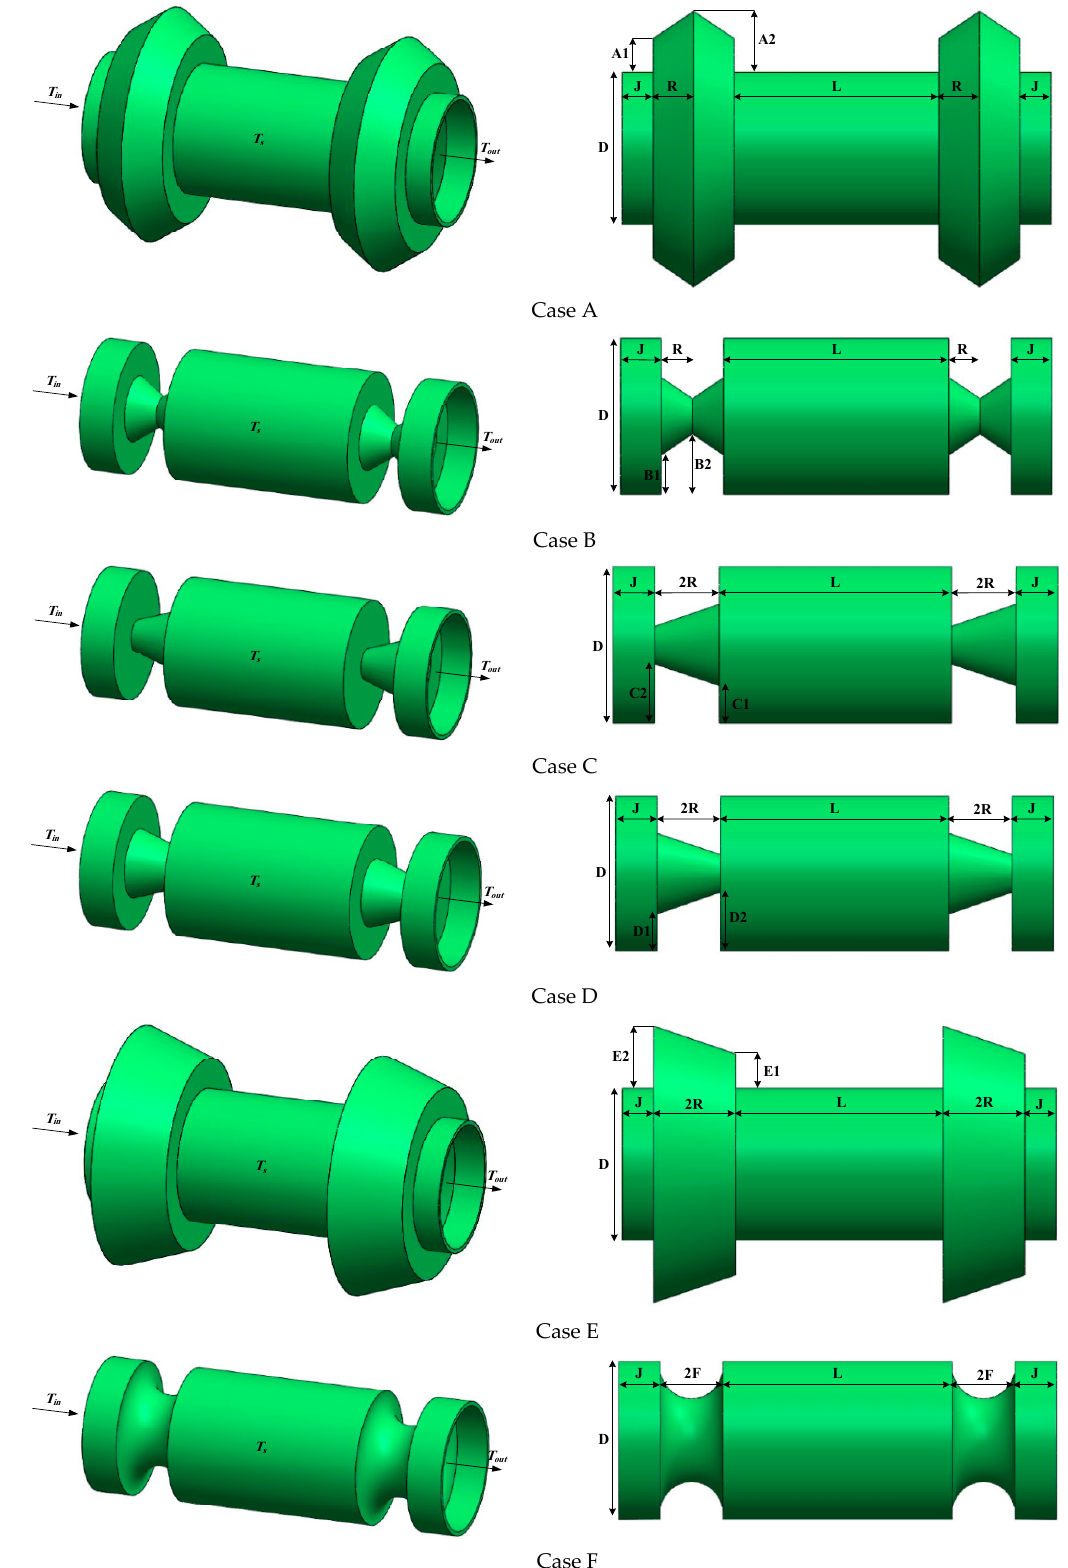
Figure 1. Schematic of heat exchangers with different wall shapes and boundary conditions . Table 1. Boundary conditions and geometrical data.